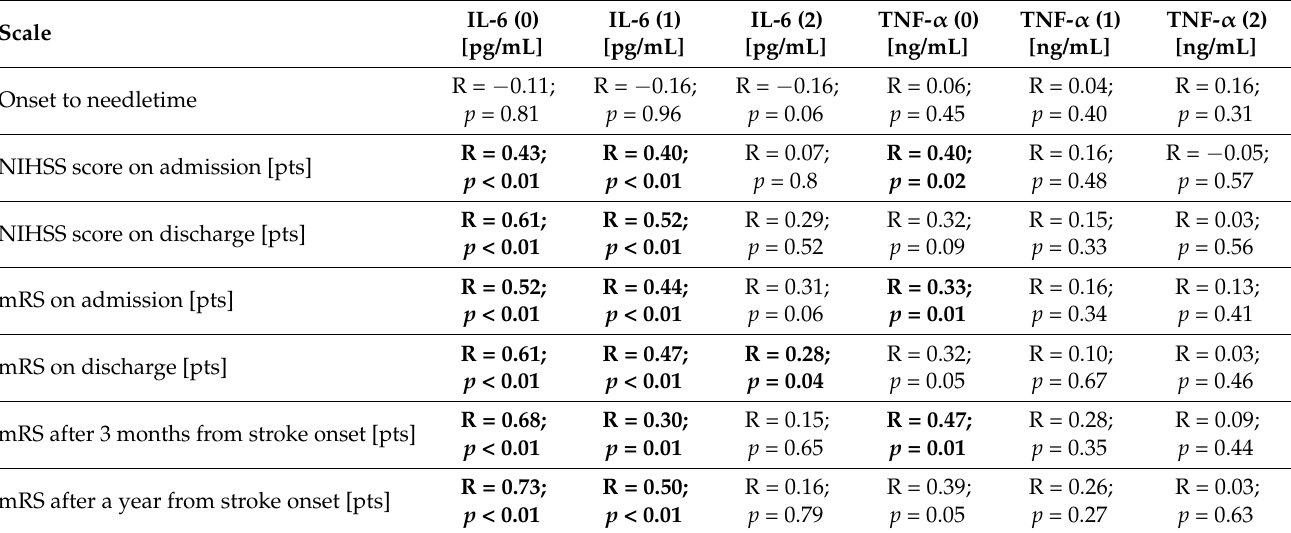
Table 4. Correlations between biochemical markers and the severity of neurological on admis- sion/discharge and functional outcome after 3 months and a year from stroke